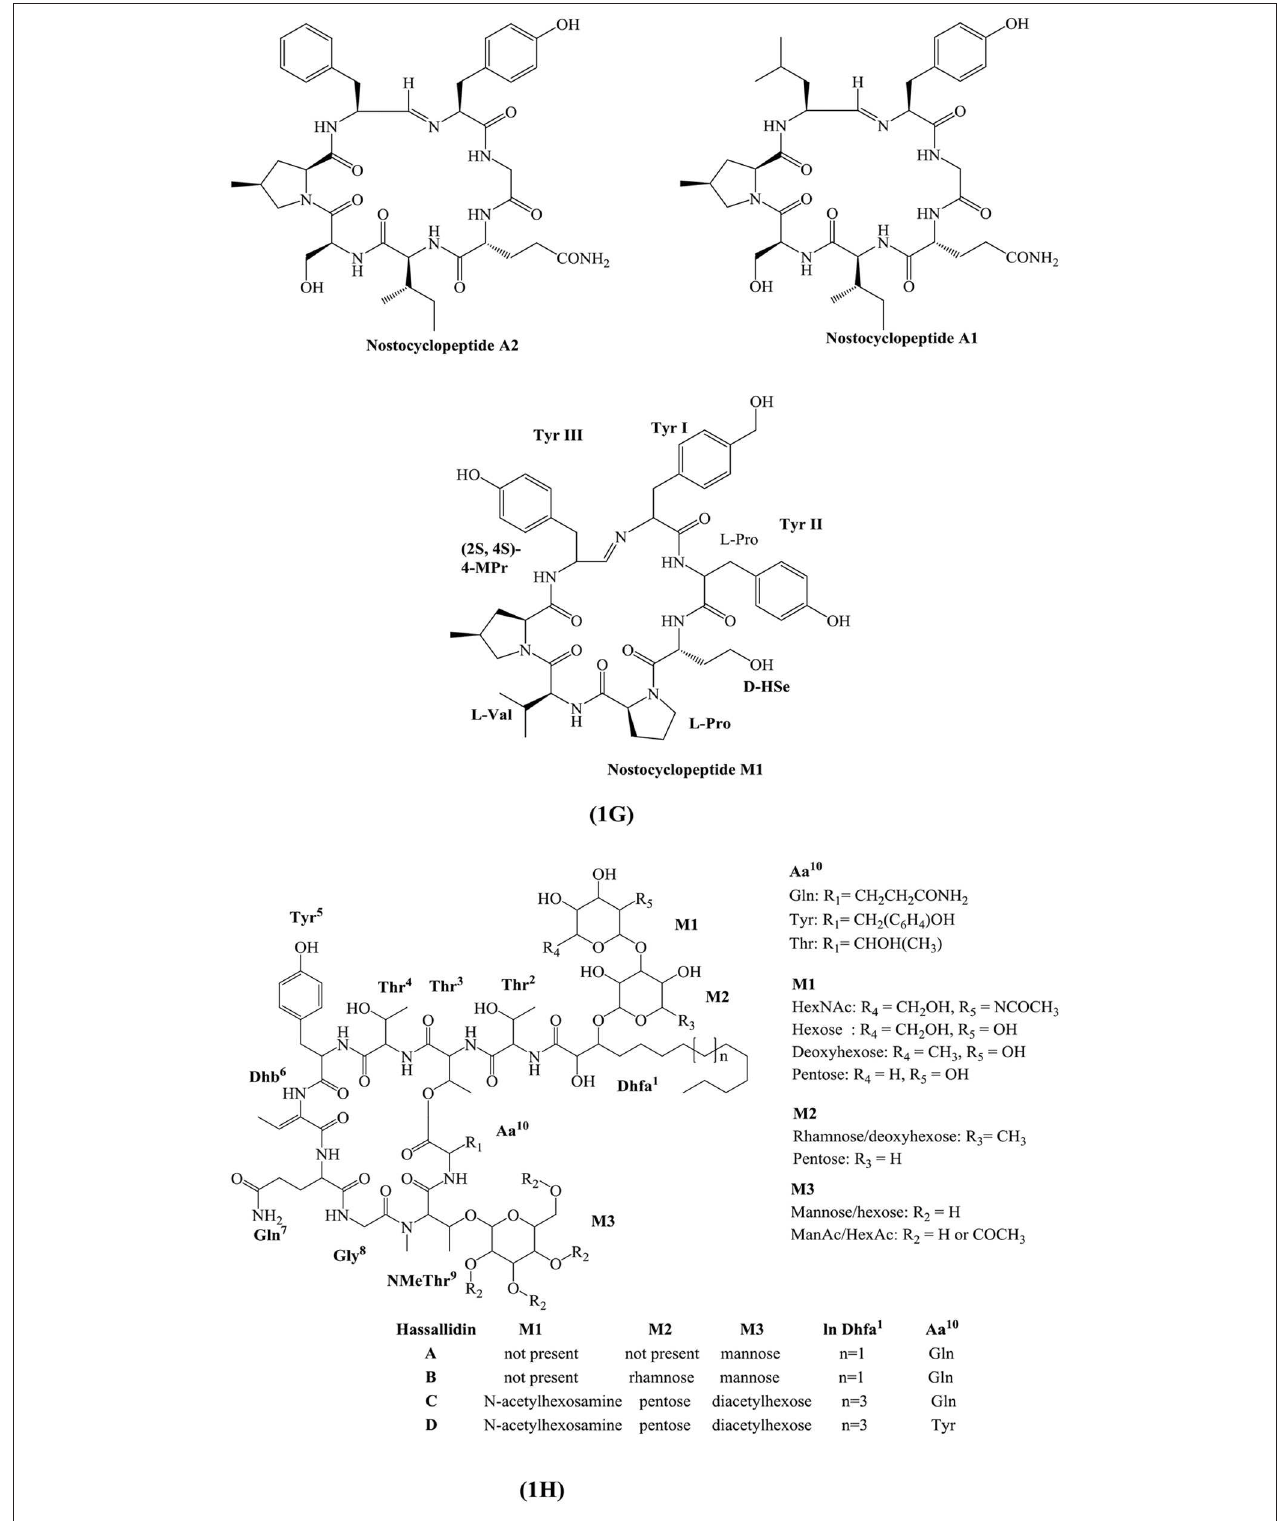
FIGURE 1 | Chemical structures of bioactive molecules from Nostoc . (A) Carbamidocyclophanes, (B) Nostoflans, (C) Cyclindrocyclophanes, (D) Merocyclophanes, (E) Scytonemins, (F) Cryptophycins, (G) Nostocyclopeptides, (H) Hassallidins.